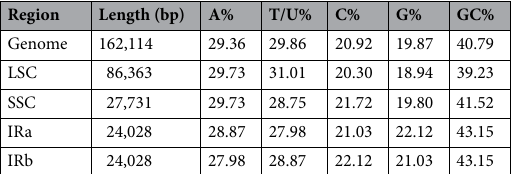
Table 1. Chloroplast genome composition of S. lepifera